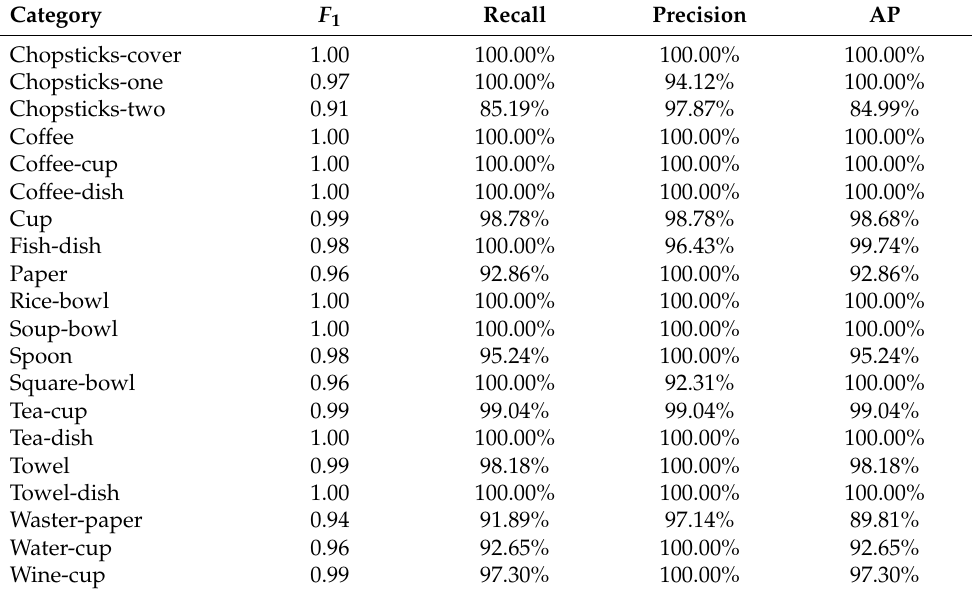
Table 7. Test results of YOLO-GD quantization model on different dish classes.